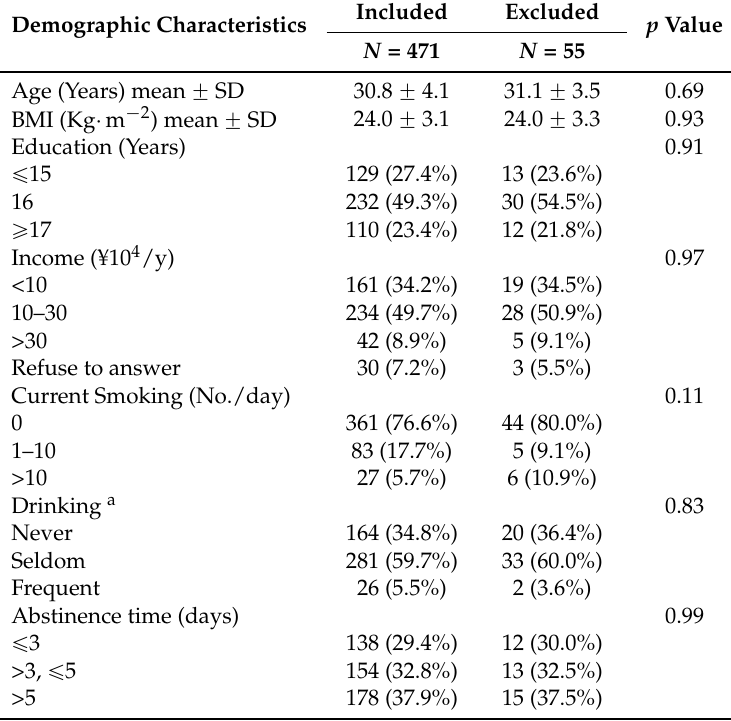
Table A1. Distribution of demographic characteristics between included and excluded volunteers.